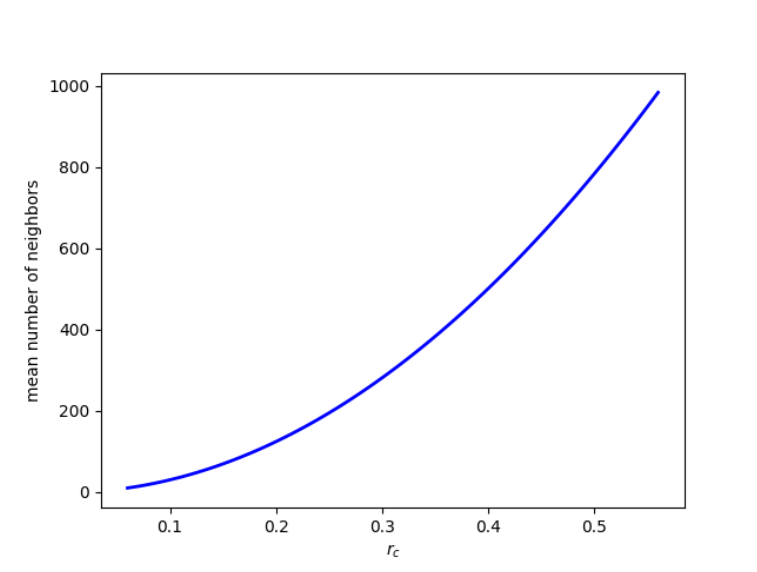
Figure 4. Mean number of neighbors depending on the radius r c for a geometric random graph of 1000 nodes.